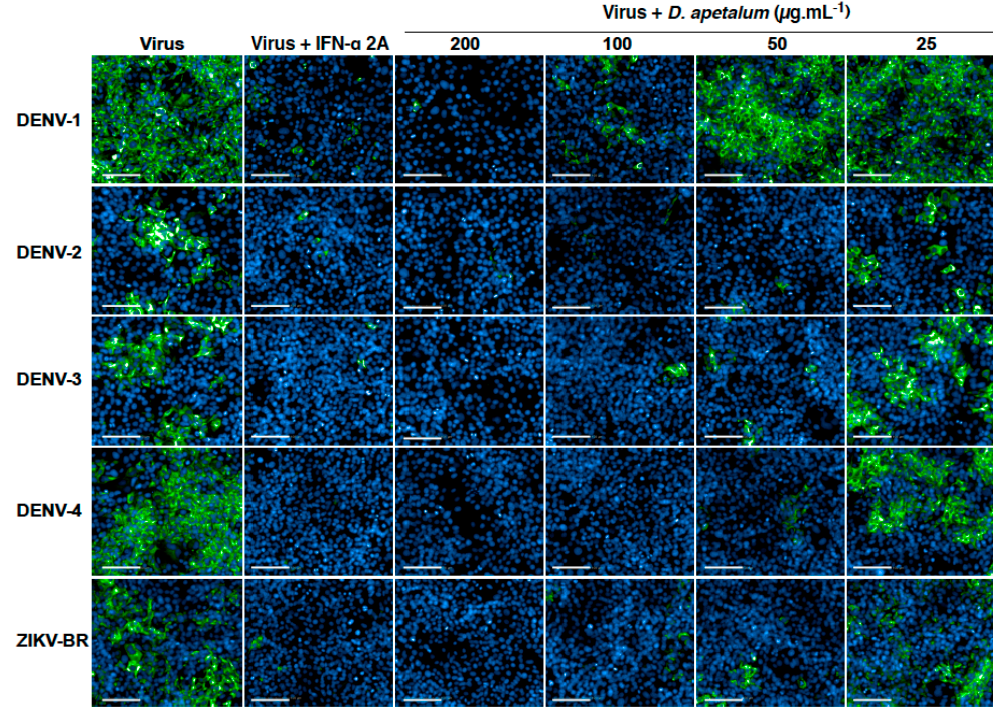
Figure 3. D. apetalum extract exhibits antiviral effect against the four Dengue virus (DENV) serotypes and an epidemic Brazilian strain of ZIKV. Huh7.5 cells were infected during 48 h with DENV-1 (MOI 2), DENV-2 (MOI 2), DENV-3 (MOI 0.5) or DENV-4 (MOI 2). Cells were infected for 48 h with the epidemic Brazilian strain (ZIKV-BR) of ZIKV at MOI 2. Infected Huh7.5 cells were continuously incubated with different non-cytotoxic concentrations of D. apetalum extract for 48 h. Recombinant IFN- α 2A (200 IU · mL − 1 ) was added 2 h post infection and used as a positive control. Immunofluorescence assay was performed using anti-flavivirus E mAb 4G2. The percentage of immunostained cells was determined using the Operetta High-Content Imaging System. Scale bars are 100 µm. Table 1. Cytotoxicity and antiviral activity of D. apetalum extract. Virus